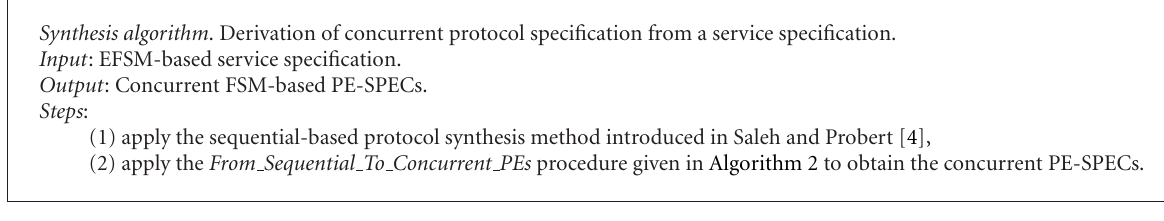
Algorithm 1: The synthesis